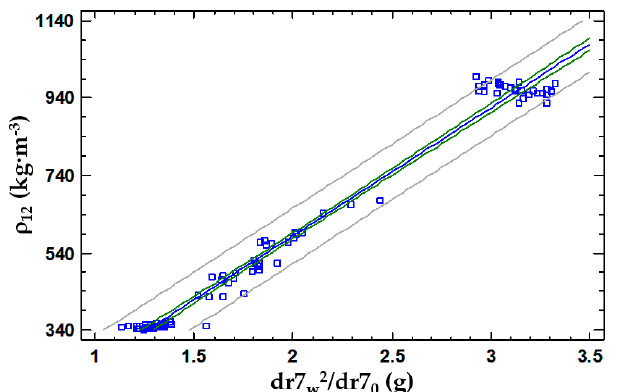
Figure 9. Linear regression model of the density of the specimen adjusted at 12% MC according to dr7 w and dr7 0 .